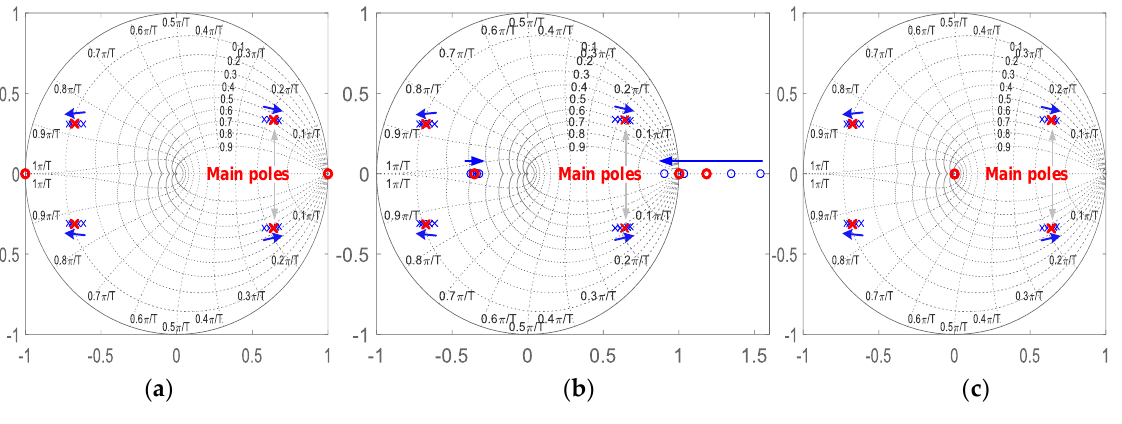
Figure 12. Zero/pole trajectories when the inductance deviates from 0.8 L to 1.2 L ( a ) F vl ( z ) ( b ) F vg ( z ) ( c ) F vr ( z ).